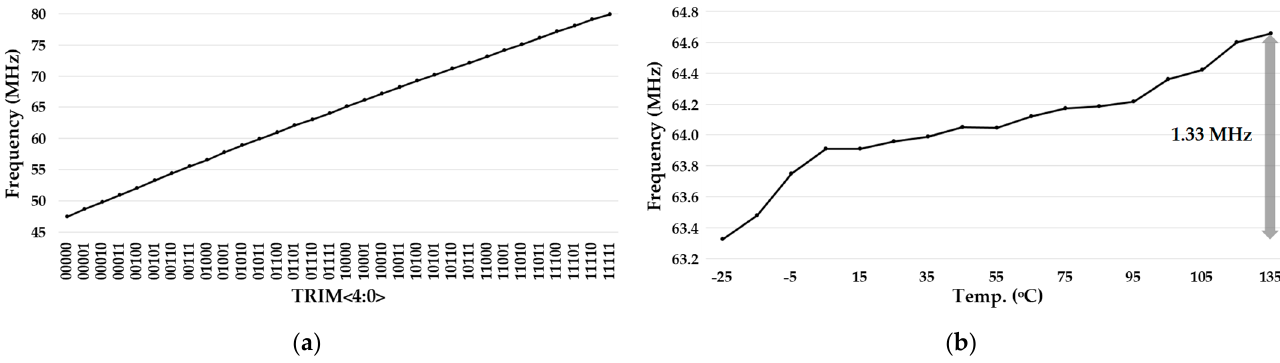
Figure 10. Measurement results for the output frequency clock of the proposed relaxation oscillator ( a ) over a wide frequency range from 47.5 MHz to 80 MHz, and ( b ) over a wide temperature range from − 25 °C to 135 °C.